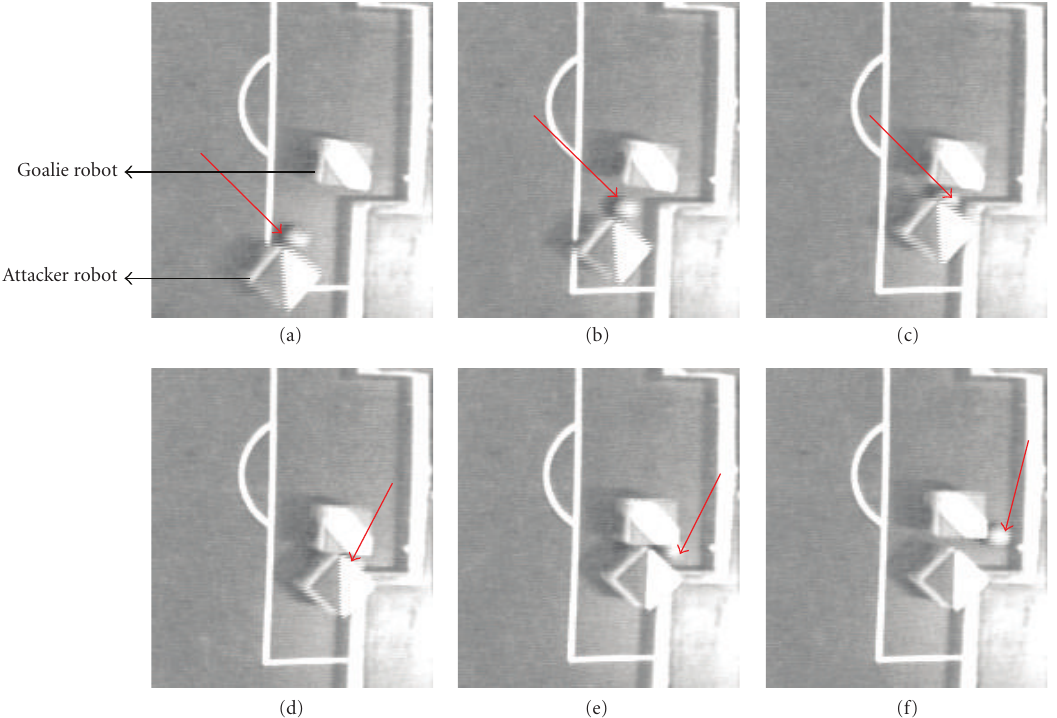
Figure 15: Six real time frames to decide charging foul behavior (a-b) The attacker is approaching the goalkeeper from the side area (c) Two robots are about to collide (d) The attacker strikes the goalkeeper (e-f) The goalkeeper bounces backward and the ball goes into the goal area (Note that the arrow head in between robots is the ball position).